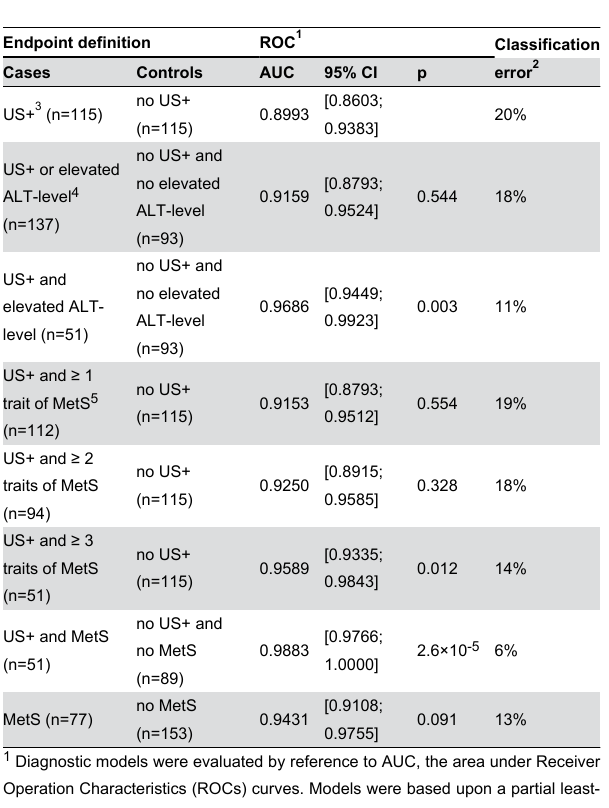
Table 4. Model parameter estimates for selected metabolites most prominent in single linear regression (p<0.05 adjusted model) and/or partial least-squares discriminant analysis